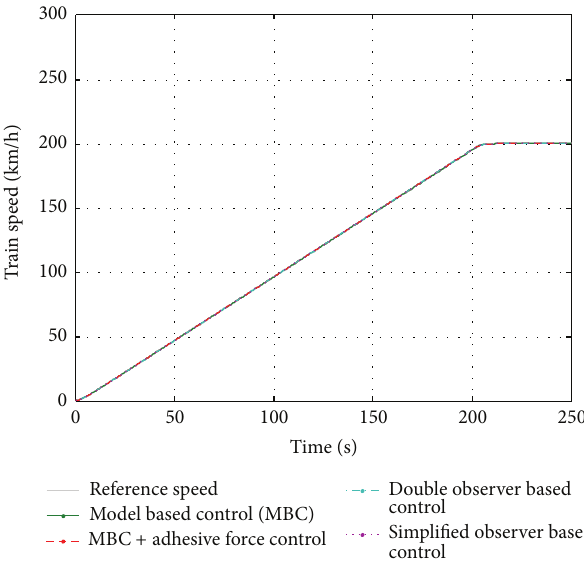
Figure 5: Evolution of the train speed.